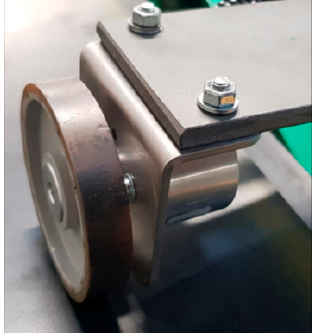
Figure 4. View of the incremental encoder in contact with the belt in the test area.